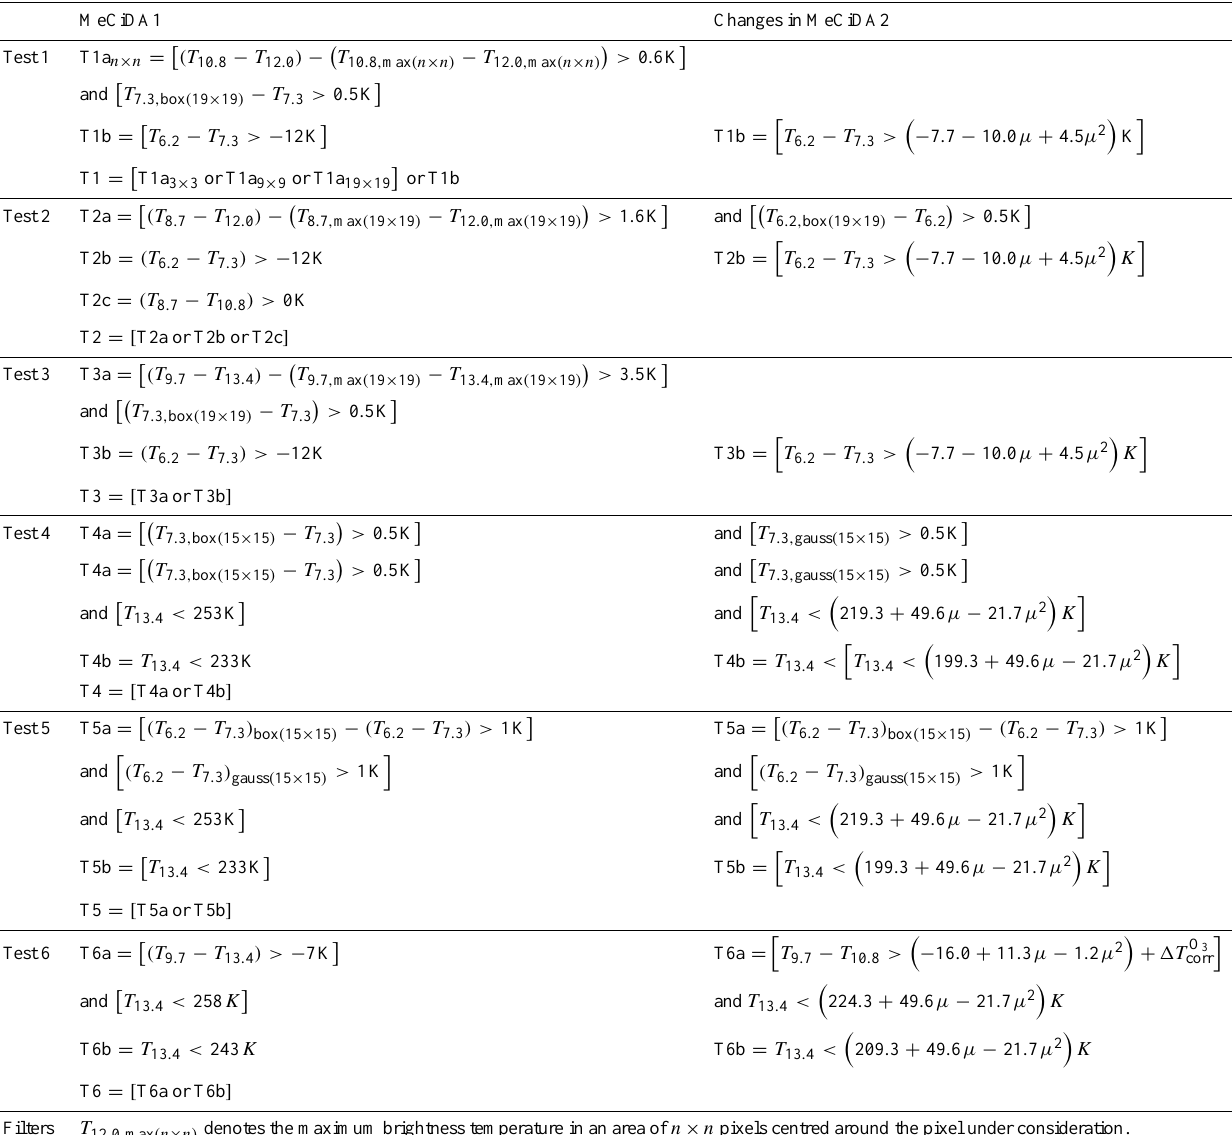
Table 2. Summary of the six cirrus tests and explanation of the filters used for the MeCiDA from Krebs et al. (2007) (called here MeCiDA1) and changes introduced in the revised cirrus tests that form the current version of the algorithm (called here MeCiDA2). Each individual cirrus test is contributing to the resulting cirrus